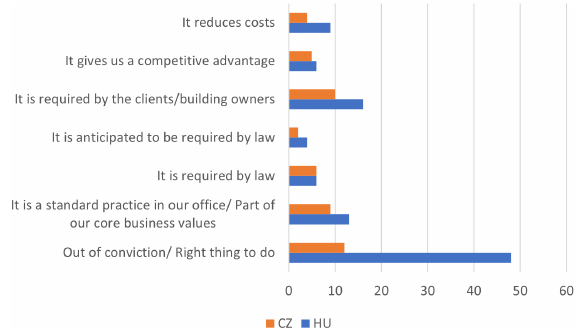
Figure 5. Responses to the question: Do you consider requirements and assessment results of environmental performance in your design decisions? (based on 82 responses).